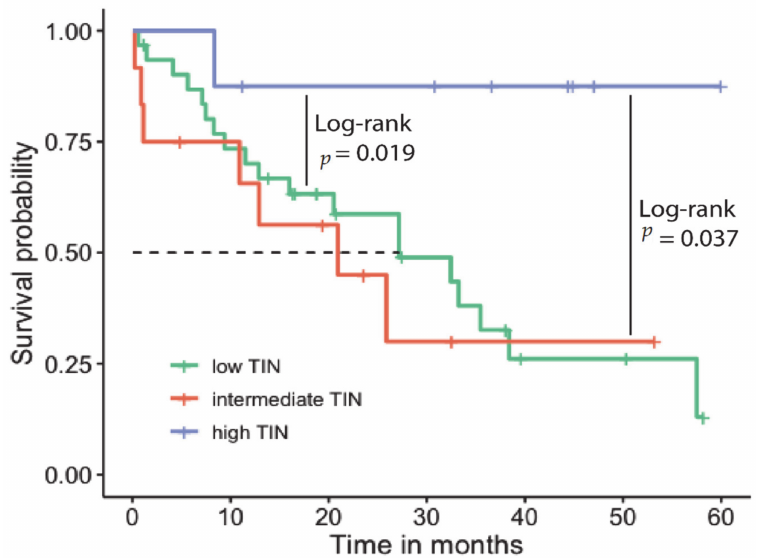
Figure 2. Kaplan–Meier (KM) plot showing survival probability stratified for tumor infiltrating neutrophiles (TIN) density. From the log-rank, only significant p -values are displayed.